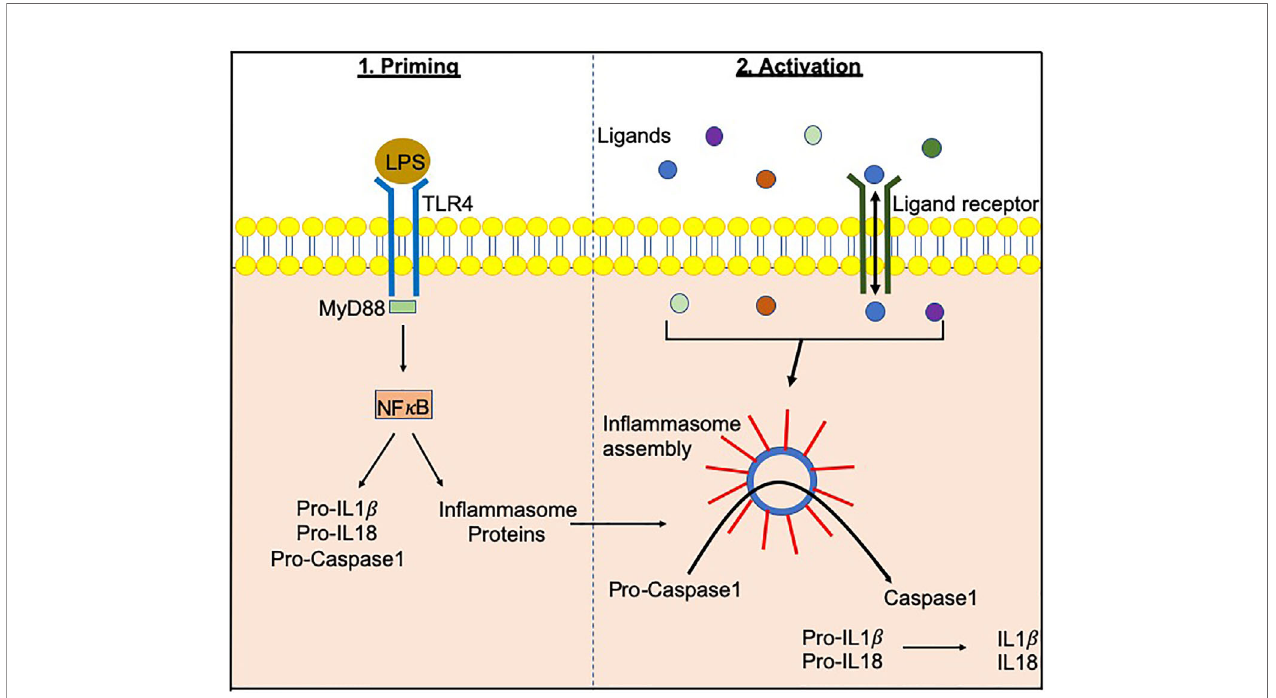
FIGURE 1 | In fl ammasome priming and activationIn fl ammasome-related genes e.g. NLRP3, NLRC4 are transcribed following PAMP/DAMP recognition by their respective receptors e.g. bacterial Lipopolysachharide (LPS) recognition by TLR4 pathogen-associated molecular patterns. This “ priming ” step alerts the cells to potential dangers and prepares the in fl ammasome machinery to be translated. Upon recognition of additional activating signals ( Figure 2 ), the in fl ammasome proteins oligomerize and form a wheel/disk-like structure. The formation of these in fl ammasome complexes enables the activation of caspase 1 from its precursor form (procaspase 1), which in turn activates other cytokines including IL-1 b and IL-18 (5, 6). In fl ammasome-associated proteins can also activate other caspases including caspase 4, 5, 8 and 11 (7 –